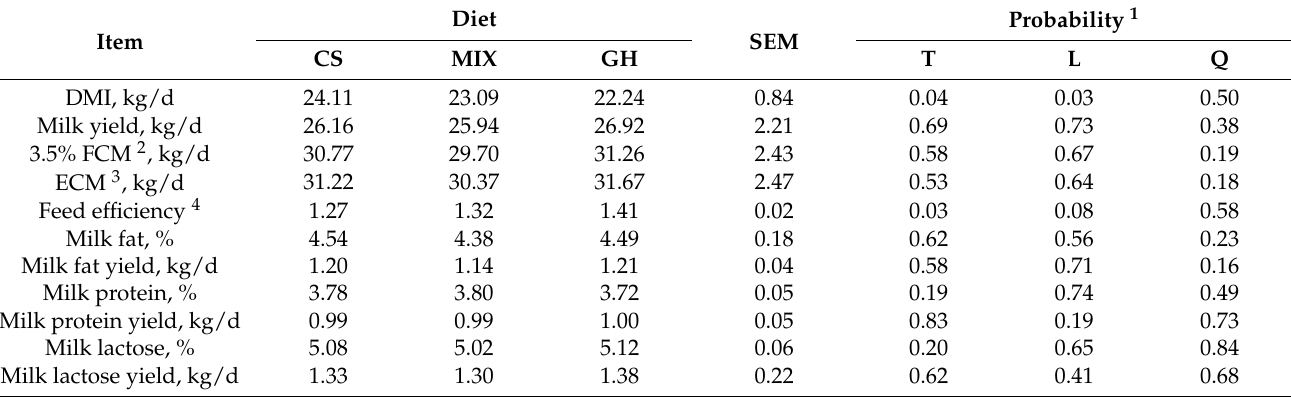
Table 3. Effects of different forage sources on dry matter intake (DMI) and lactation performance of cows.